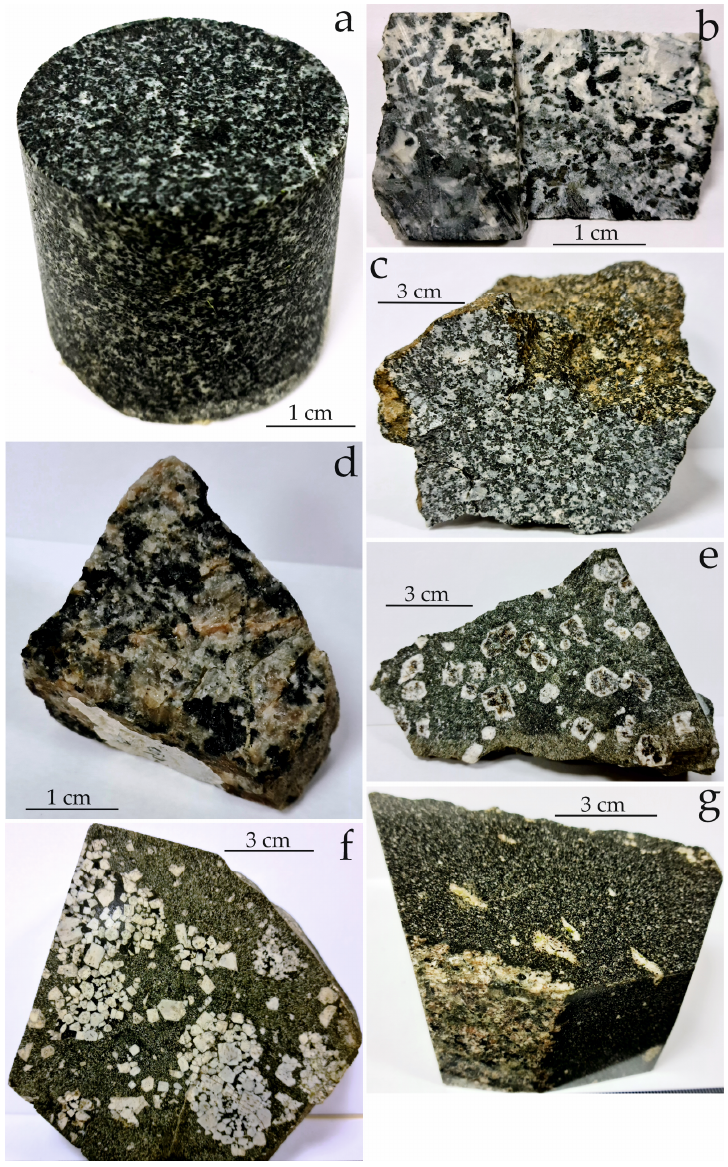
Figure 3. Macrophotography of the main petrographic varieties of the University pluton: ( a ) melanogabbro (sample 36 / 147.0) and ( b ) leucogabbro (sample 41 / 87.0); and the crosscutting N-trending dike rocks: ( c ) plagioclase ijolite (sample 6A); ( d ) leucotheralite (sample 8A); ( e ) ijolite-porphyry (sample 8 / 19); ( f ) urtite xenolith in ijolite-porphyry (sample KC-7 / 1) and ( g ) analcime syenite (globule) in fine-grained ijolite (sample